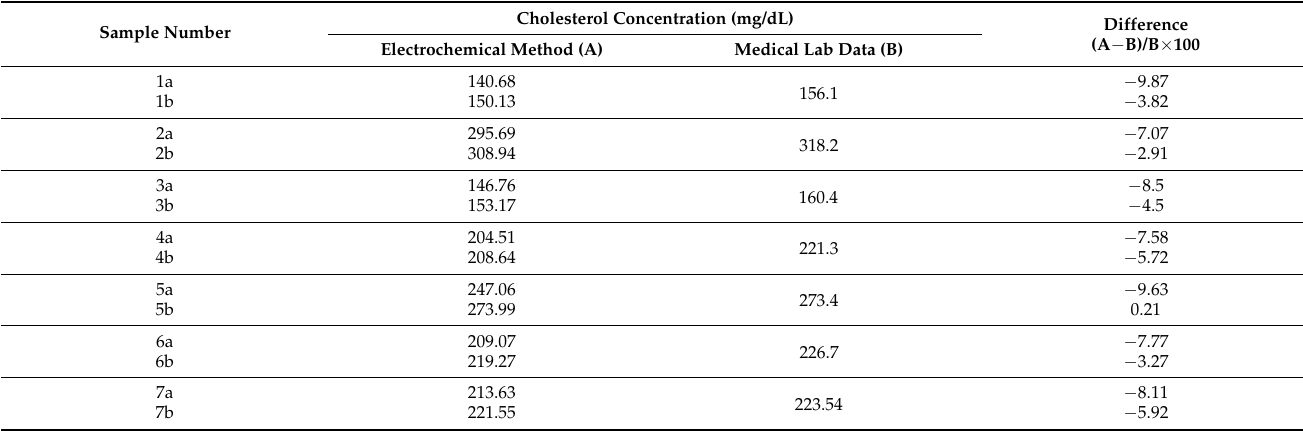
Table 3. Serum sample analysis using the developed electrochemical method and compared to medical laboratory